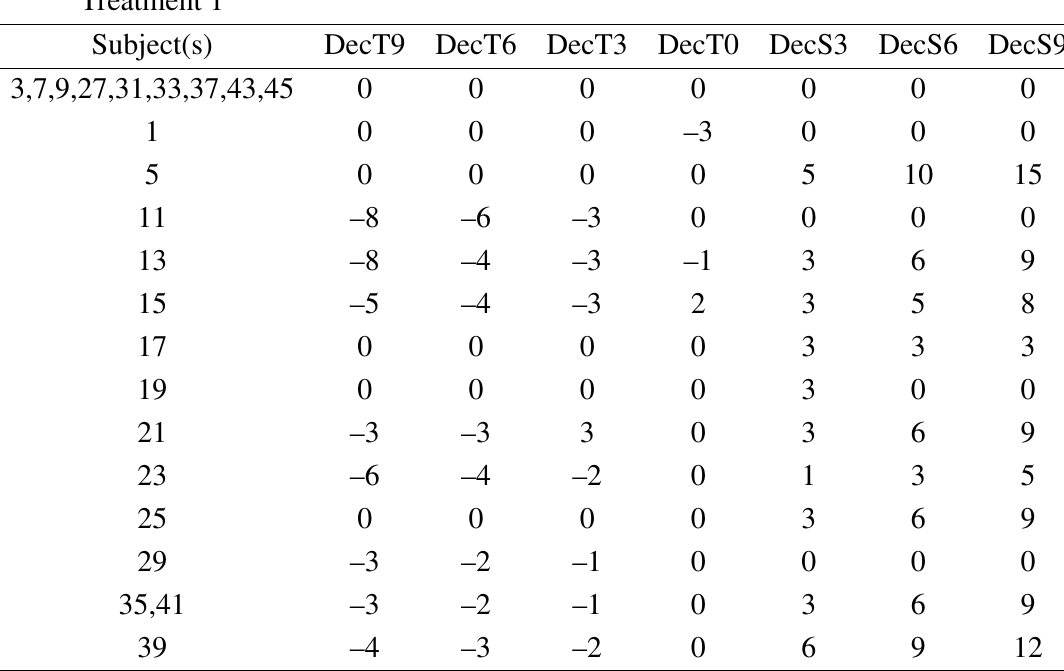
Table 2 . Player 2 behavior in the Moonlighting-game with almost equal endowments (Treatment 1). DecT x and DecS y are the decisions of Player 2 after Player 1 has taken x EMU or sent y EMU, respectively, where sending y implies gains of 3 y for Player 2. A positive value indicates the number of EMU sent back, a negative value the number of reduction points assigned, where each reduction point costs 3 EMU to player